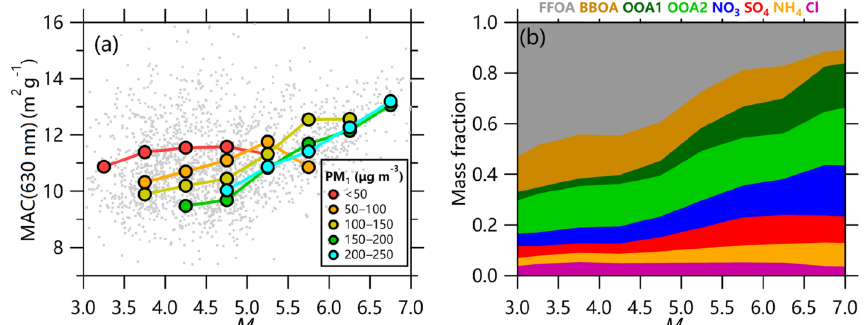
Figure 9. (a) Variations of MAC as a function of M R at different pollution levels and (b) variations of mass fraction of rBC-coated species as a function of M R